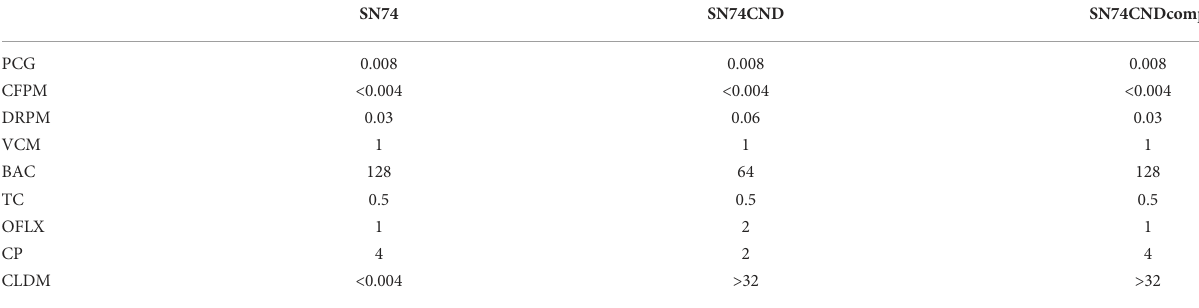
TABLE 6 Antibiotic resistance test; Minimum Inhibitory